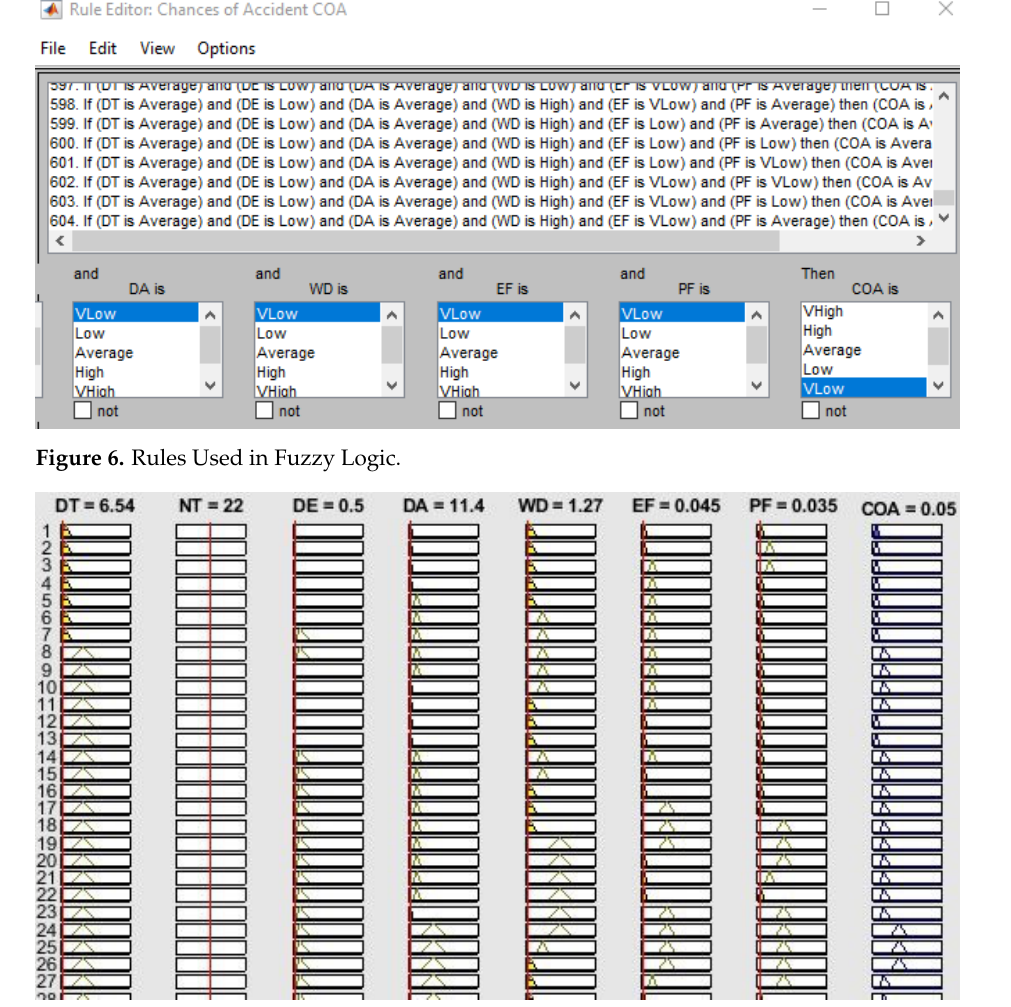
Figure 7. Testing the COA on Rule Viewer with Input as Day Time (DT), Night Time (NT), Driver’s Experience (DE), Driver’s Age (DA), Weekday (WD), Environmental Factors (EF), Physical Factors (PF).